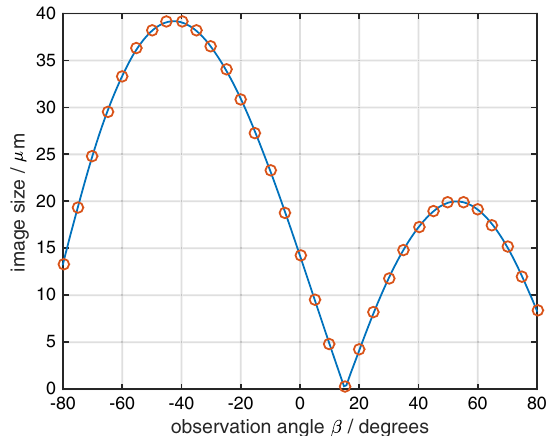
FIG. 3. Ray tracing results of the image size (red circles) agree with the analytical expression (1) (blue line).